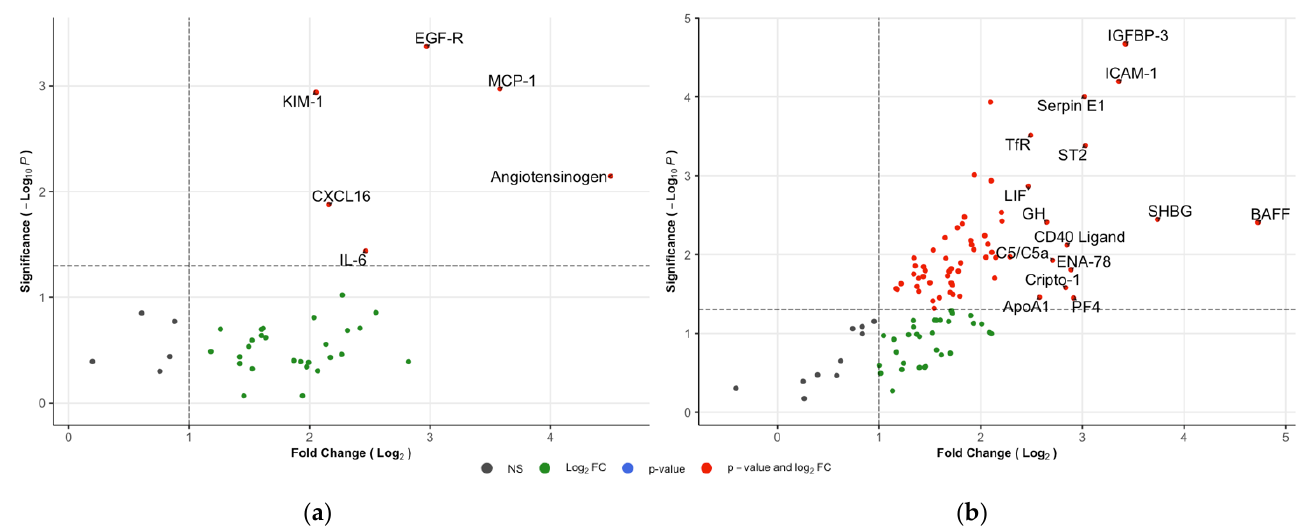
Figure 3. Volcano plots of IgAVN vs. IgAVwoN: ( a ) Kit K; ( b ) Kit C. The horizontal lines represent the statistical significance cut off (−log10(0.05)). Vertical lines represent the fold-change cut-off (log2(2.0)). Fifteen top hits in term of FC are labelled in ( b